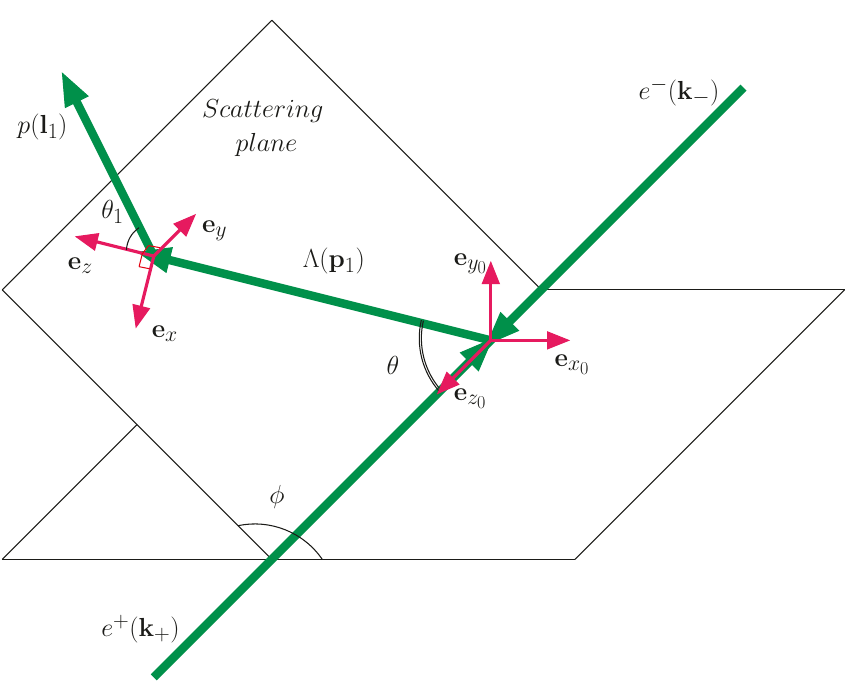
e e x 0 ; y 0 ; z 0 ) and (cid:3) frame coordinate